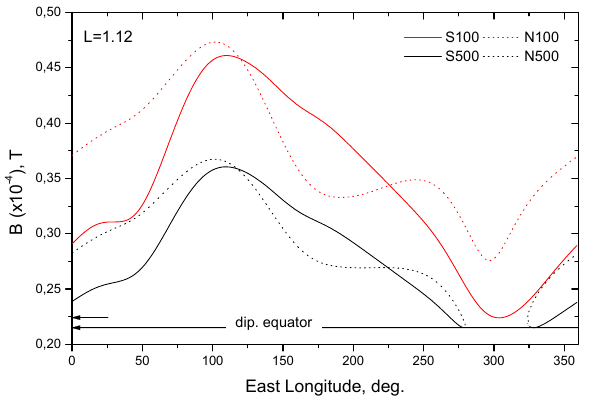
Fig. 3. Same as Fig. 2 for the magnetic shell L = 1 . 12.